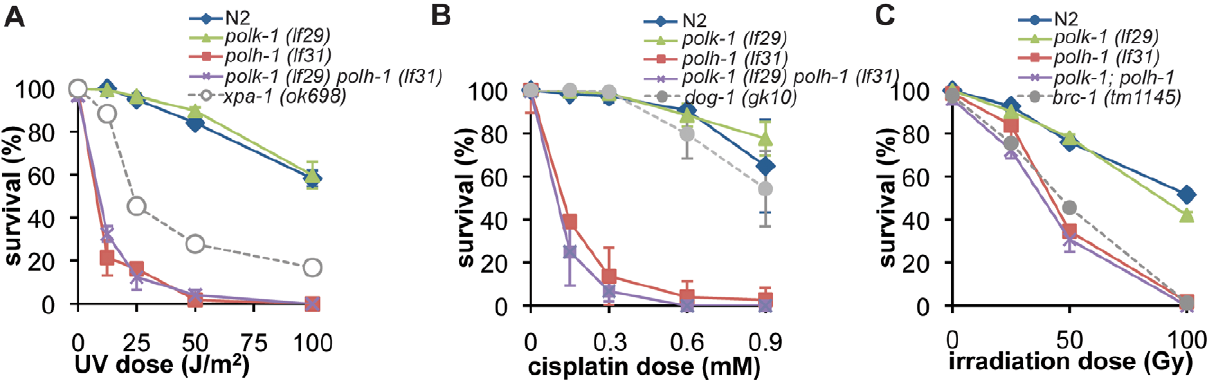
Figure 2. Germline sensitivity of polh-1 and polk-1 mutants to different sources of DNA damage. (A) Sensitivity to UV-irradiation. (B) Sensitivity to c -irradiation. (C) Sensitivity to cisplatin. Adults were exposed to DNA damaging treatments and survival was quantified by counting dead embryos versus living progeny in the next generation. Each line represents the mean of minimal three independent experiments. Error bars denote the s.e.m.